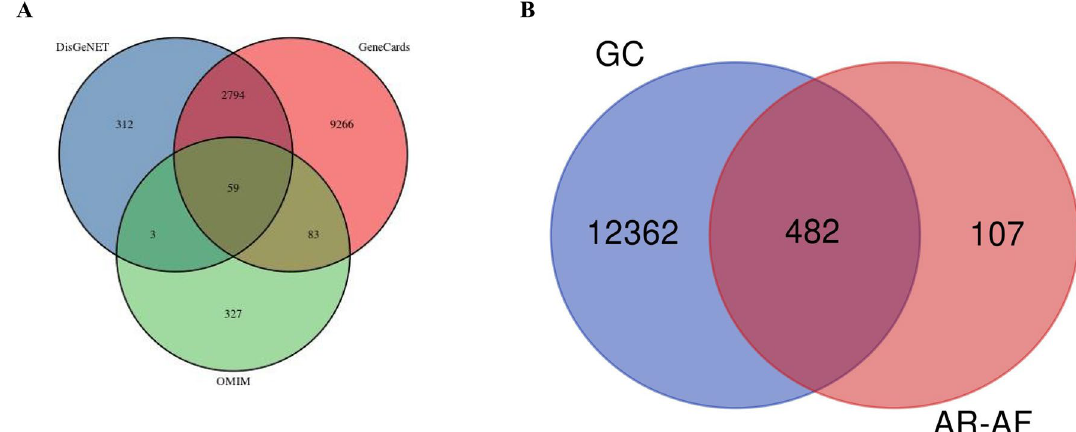
Figure 3. Venn diagram of target genes. ( A ) GC-related targets in different databases. ( B ) Venn diagram of AR-AF and GC targets.